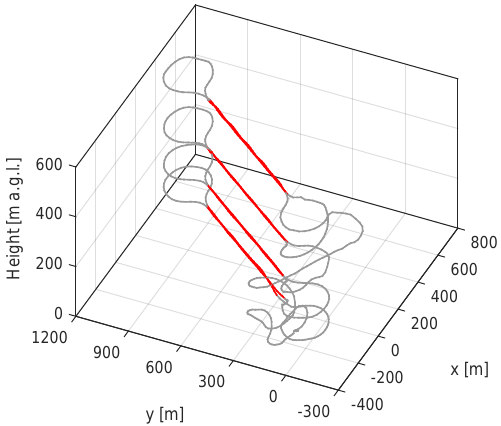
Figure 2. Typical flight pattern for the turbulence measurements from SUMO during the BLLAST campaign. Turbulence parameters are only evaluated for the straight legs (red). This example is from flight no. 38 at 09:15UTC on 27